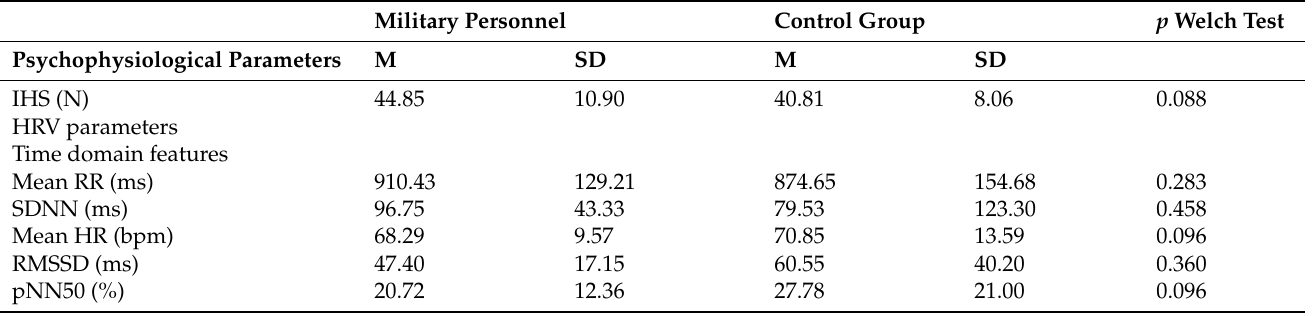
Table 1. Psychophysiological parameter differences between military personnel and control